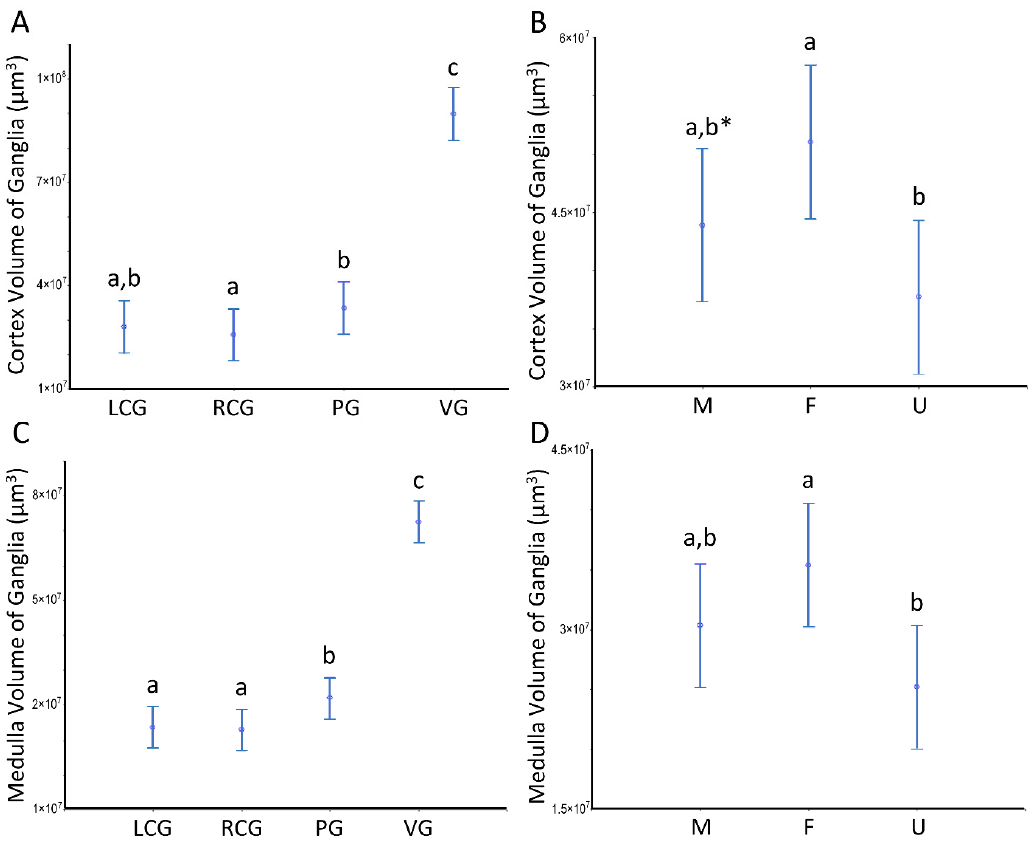
Figure 6. Volumes of the ganglia cortex and medulla of S. plana . ( A ) Cortex per ganglion. ( B ) All cortexes per sex condition. ( C ) Medulla per ganglion. ( D ) All medullae per sex condition. Different letters mean significant differences ( p < 0.05). Data as mean and 95% confidence interval. LCG, RCG, PG, VG, M, F, and U as in Figure 5. * Trend toward a significant difference between M and F ( p ≈ 0.05). Six animals per sex condition were used. The V V (cortex, ganglion) and V V (medulla, ganglion) per sex condition are displayed in Tables 3 and 4. In all ganglion types, the cortex occupies over 50% of the total volume. There are no differences concerning the sex condition effect. However, the analysis reveals a significant effect for the ganglia type ( p < 0.05), with the V V (cortex, ganglion) decreasing anterior-posteriorly from the cerebral ganglia (that do not differ bilaterally) toward the visceral ganglion; in contrast, the V V (medulla, ganglion) follows a significant reverse pat- tern, rising toward the visceral. The patterns and the detailed statistical differences be- tween ganglia are displayed in Figure 7.